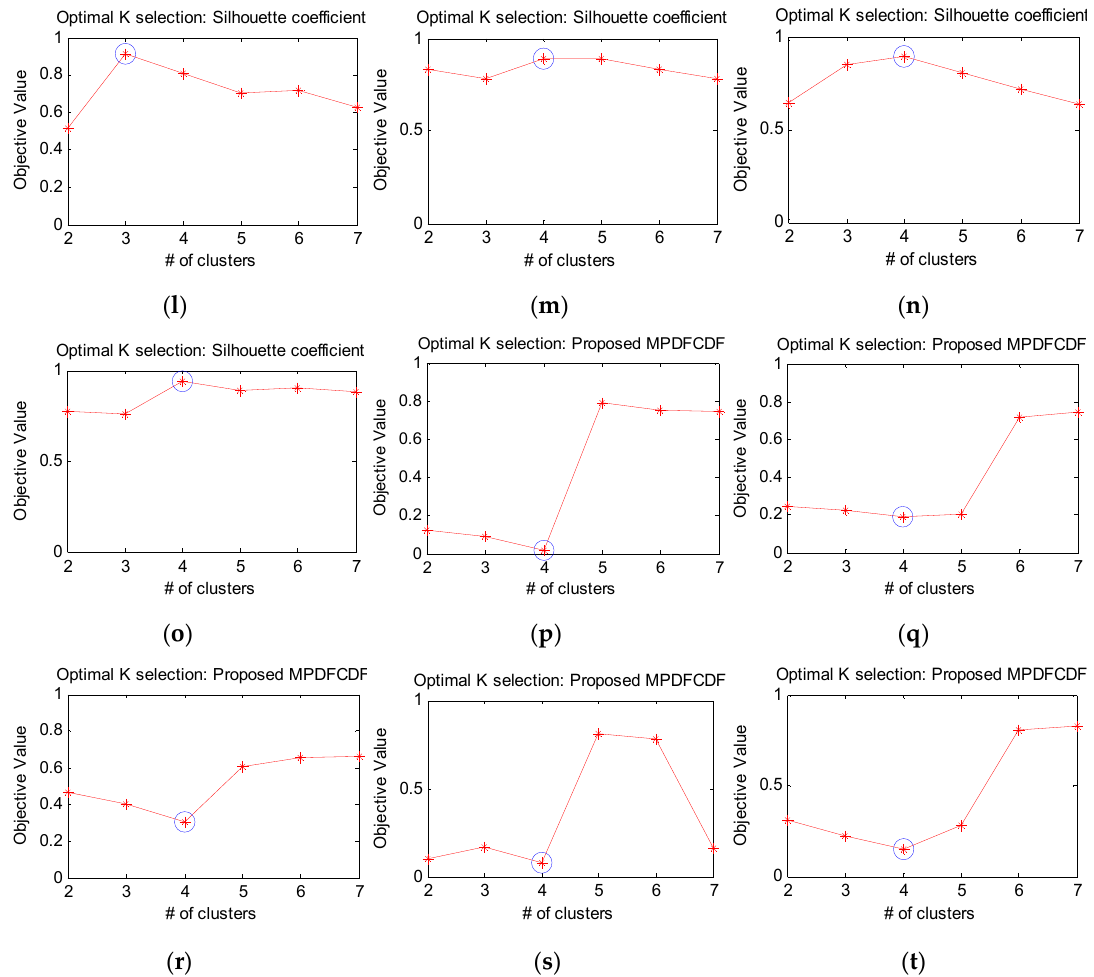
Figure 13. (a–e) Sample distribution of different datasets and optimal k opt (blue big circle) selection using the compactness and separation measure of ( f – j ) clusters (COSES) method, ( k – o ) silhouette coefficient, and ( p – t ) the proposed MPDFCDF cluster evaluation method.